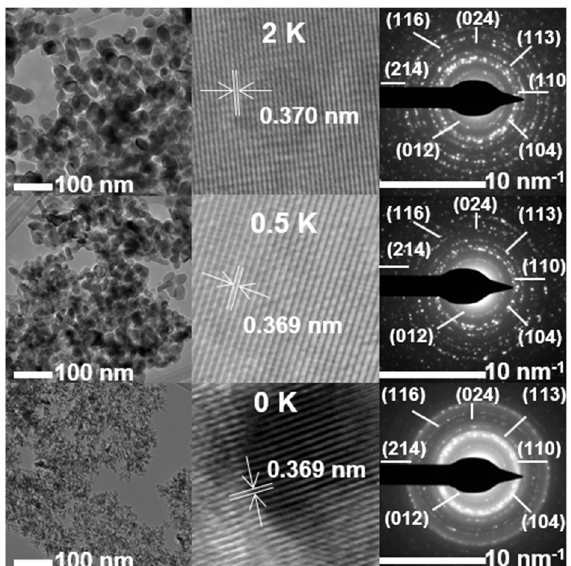
Figure 10. (From left to right) Transmission electron microscopy (TEM), high-resolution TEM (HRTEM), and selected area electron diffraction (SAED) patterns of (from top to bottom) 100 Fe:2 K, 100 Fe:½ K, and 100 Fe:0 K materials, calcined at 400 °C. Table 3. The average diameter of α -Fe 2 O 3 particles and surface potassium content ( x ) for selected materials and calcination temperatures ( T ).